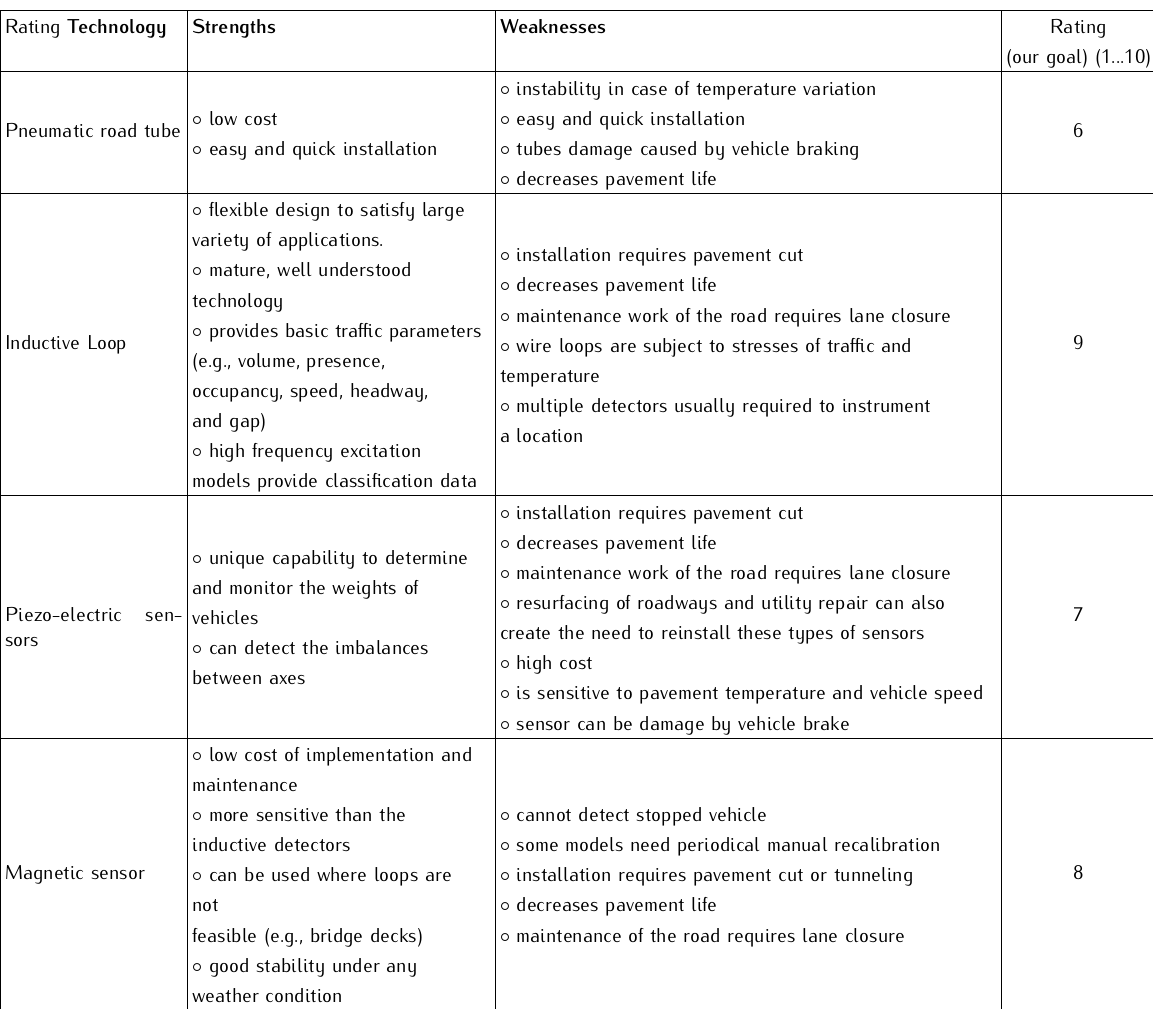
Table 1. Strengths and weaknesses of intrusive detection technology [2] Rating Technology Strengths Weaknesses Rating